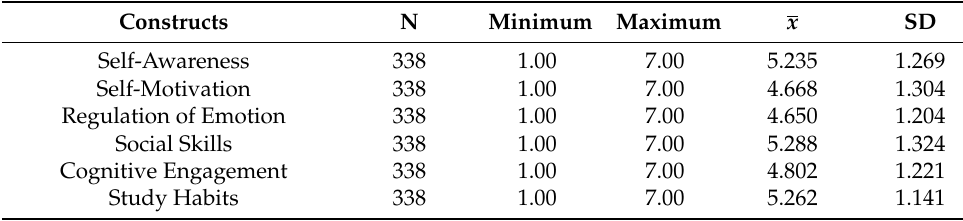
Table 6. Descriptive